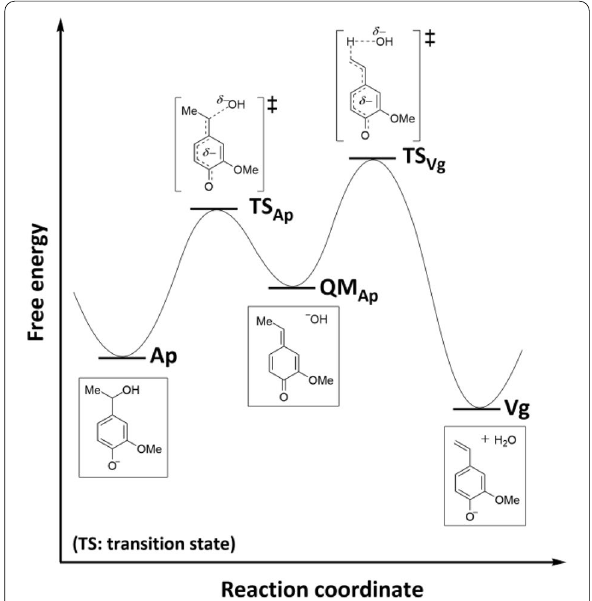
Fig. 7 Schematic potential energy diagram for the interconversion between Ap and Vg as the pre-equilibrium of condensation reactions in this